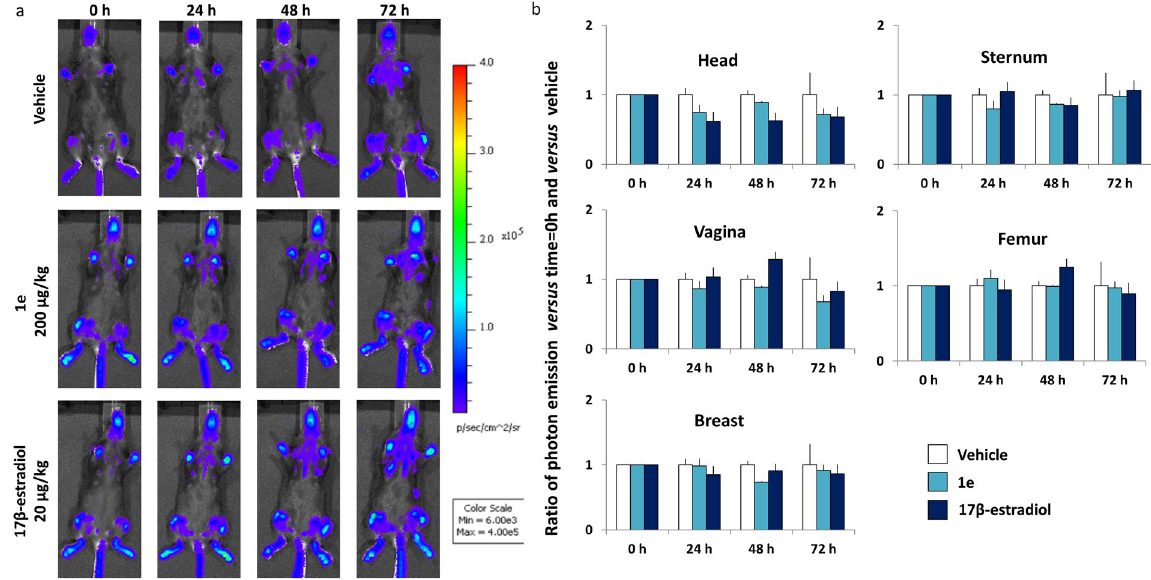
Figure 11. 1e compound does not induce proliferation at systemic level in the MITO- Luc mouse. ( a ) In vivo whole body bioluminescence imaging of MITO- Luc after indicated treatments. Photos portray whole body (ventral view) at 0, 24, 48, 72 hours after treatments in a pseudocolor image processed to indicating the intensity of photon emission in whole body. ( b ) In vivo BLI: photon emission from selected body areas were measured. Bars represent the mean ratio versus t = 0 h and vs vehicle ± SEM of photon emission measured in 4 animals/